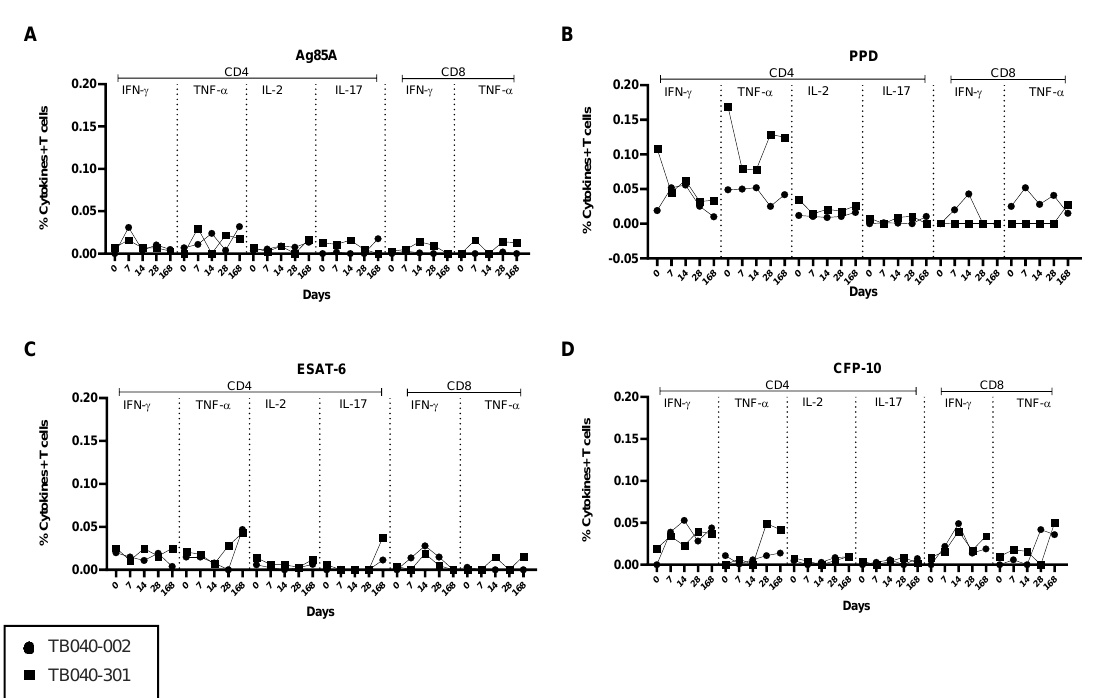
Figure 4. Peripheral blood mononuclear cell (PBMC) intracellular cytokine staining (ICS). PBMC ICS antigen-specific responses in two latent Mycobacterium tuberculosis ( M.tb) -infected UK adults vaccinated with 1 × 10 7 pfu aerosol-inhaled MVA85A. Percentages of CD4+ T cells producing IFN-γ, TNF-α, IL-2, IL-17, and CD8+ T cells producing IFN-γ and TNF-α in response to ( A ) Ag85A, ( B ) PPD, ( C ) ESAT-6, and ( D ) CFP-10. Individual values shown for each volunteer.